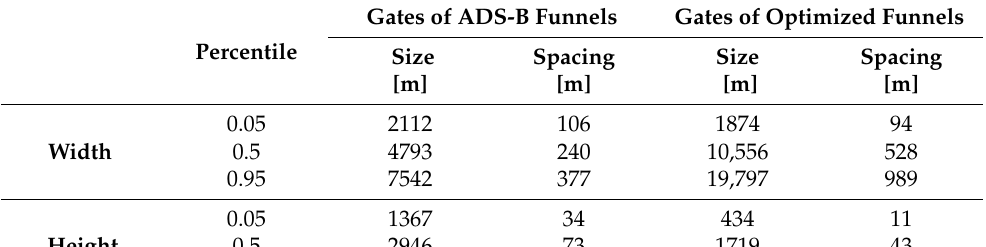
Table 3. Dimension of departure funnels and grid point spacing per gate from the ADS-B data and optimized flights.